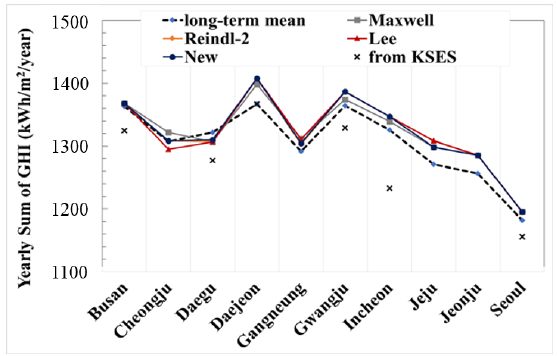
Figure 8. Yearly sums of the GHI from the long-term mean, in the TMY data from Korean Solar Energy Society (KSES), and in the TMY data generated using the Maxwell, the Reindl-2, and the new models.